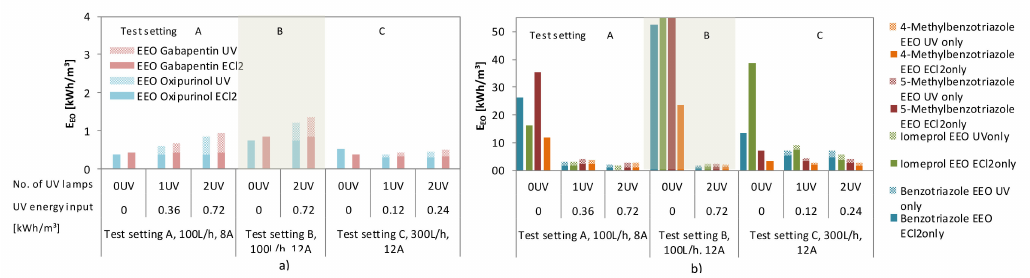
Figure 13. E EOs for gabapentin and oxipurinol ( a ) and 4-methylbenzotriazole, 5-methylbenzotriazole iomeprol and benzotriazole ( b ) calculated from three di ff erent settings during field tests with Elbe river